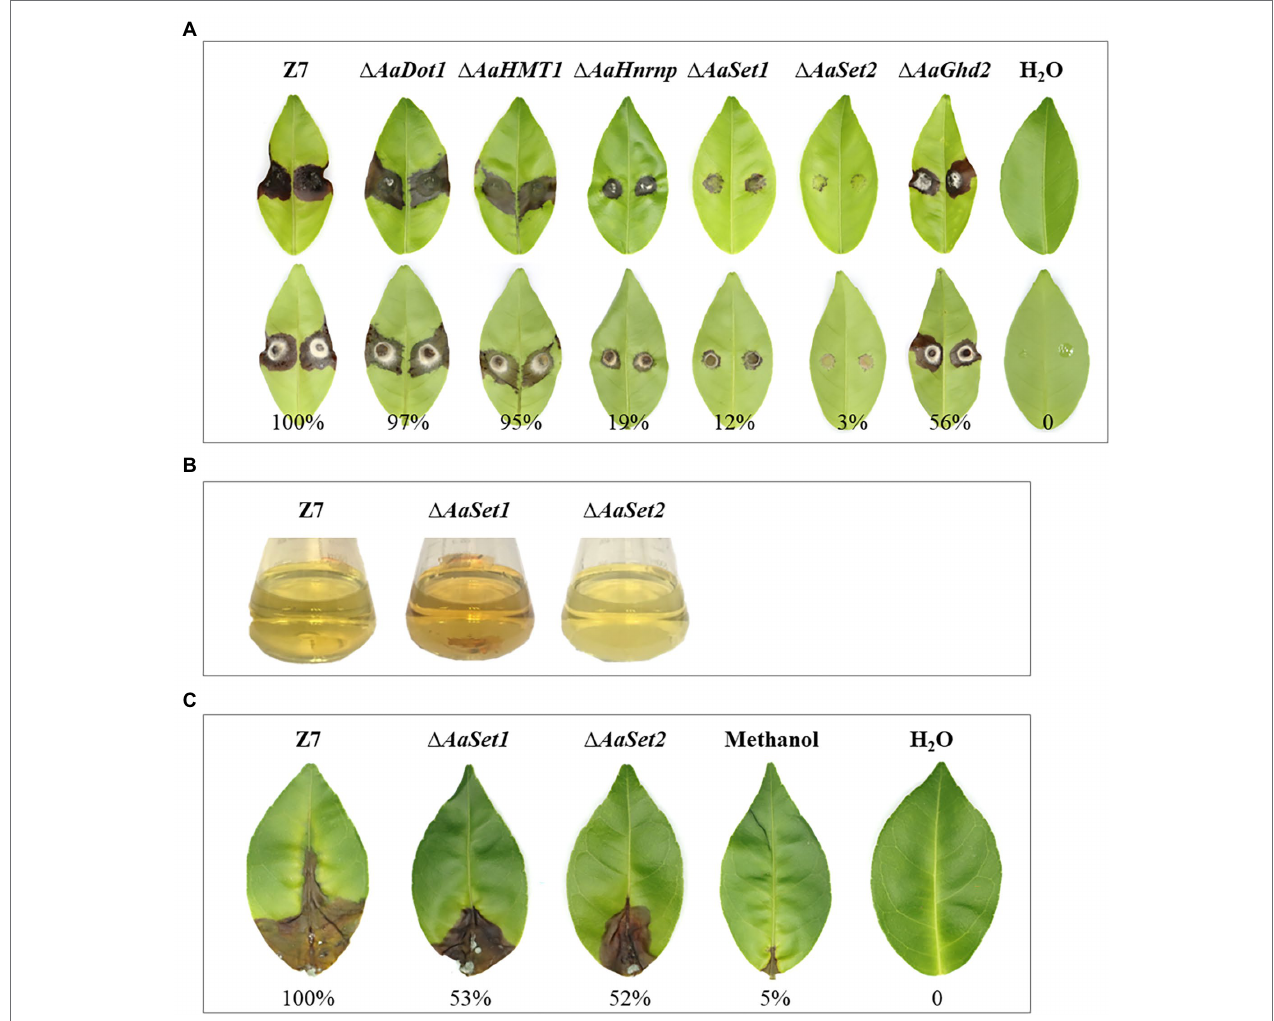
FIGURE 6 | HMTs and HDMs are required for fungal virulence. (A) Virulence assays of strains. Upper panel represents the front side of inoculated leaves, and the back side of inoculated leaves. (B) Filtrates of ∆ AaSet1 , ∆ AaSet2 and wild type. (C) ACT toxin virulence analysis of ∆ AaSet1 , ∆ AaSet2 and wild